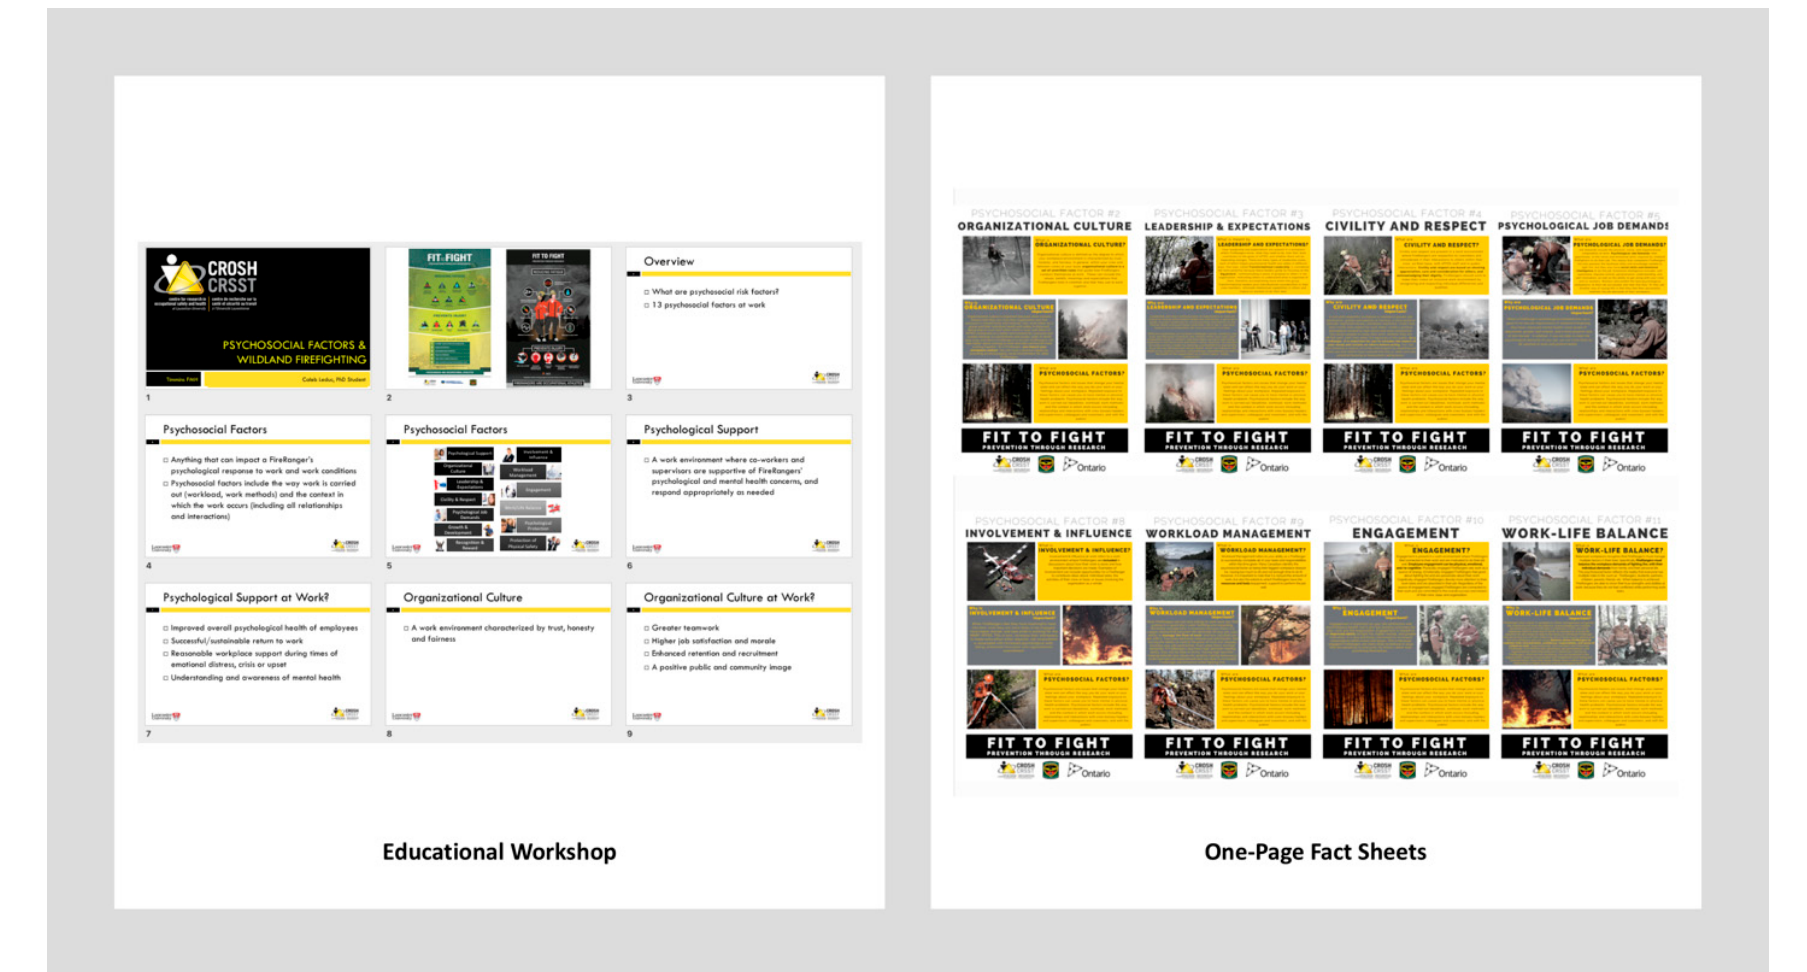
Figure 2. Psychosocial education intervention components.